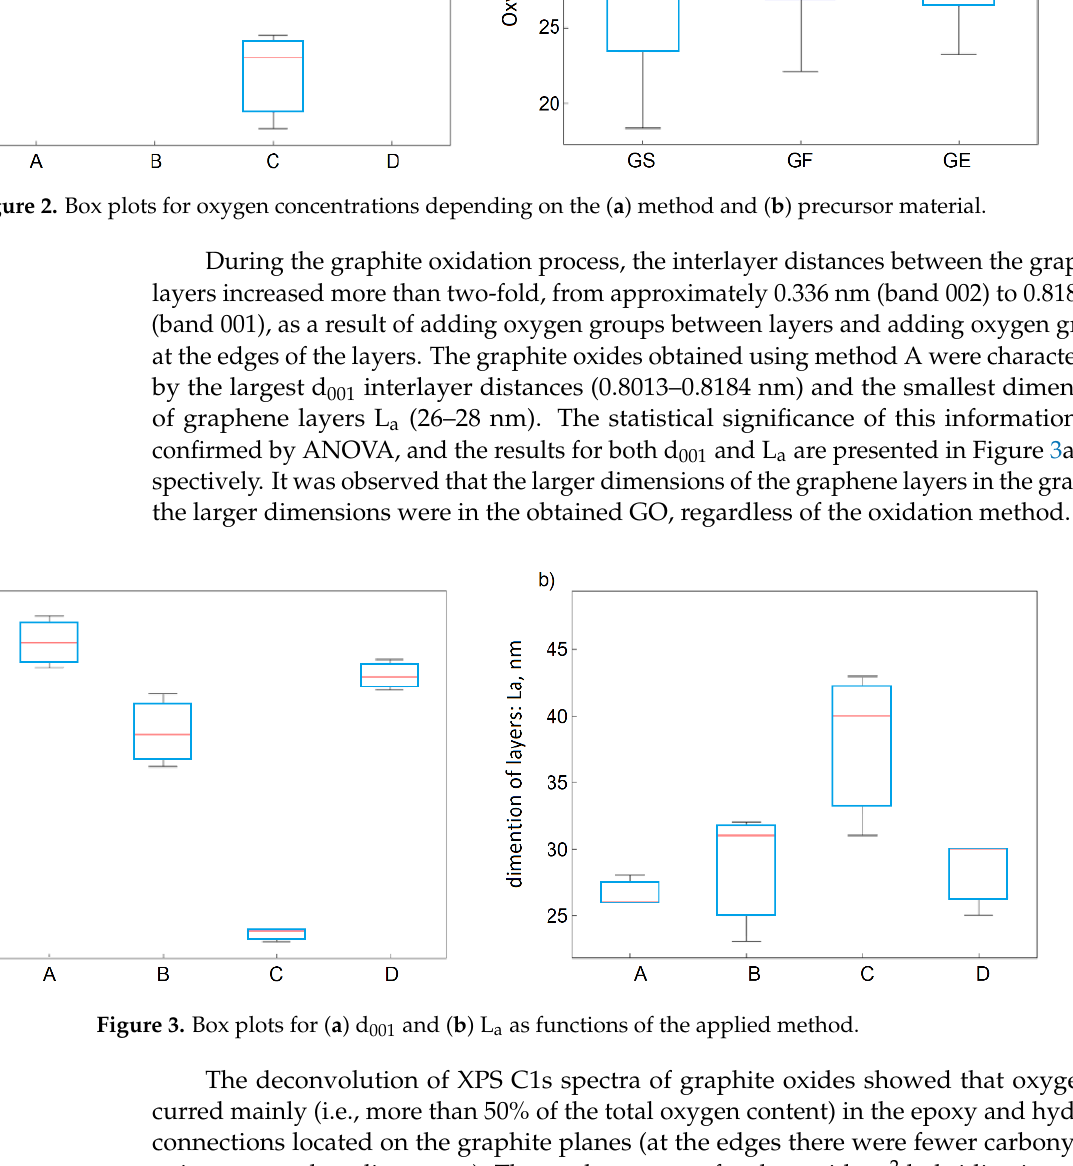
Figure 2. Box plots for oxygen concentrations depending on the ( a ) method and ( b ) precursor material.